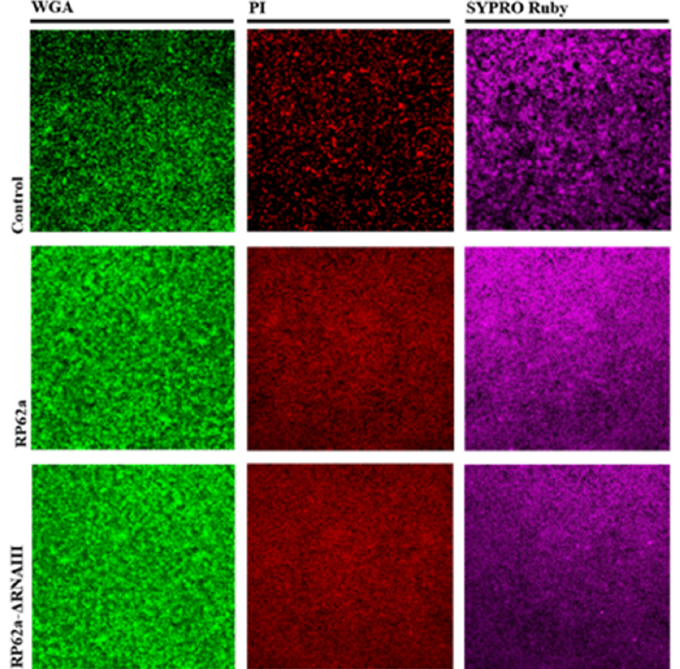
Figure 9. CLSM analysis of EPS treated with oxacillin and vanillin in S. epidermidis RP62a and RP62a- Δ RNAIII (magnification 60×). Polysaccharides were stained with WGA; proteins were stained with SYPRO Ruby Biofilm Tracer and eDNA was stained with